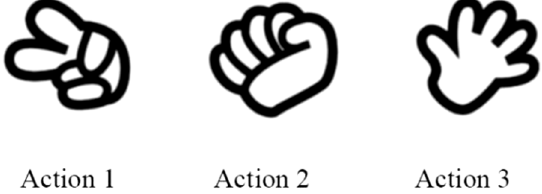
Fig. 2. Actions to be recognized.